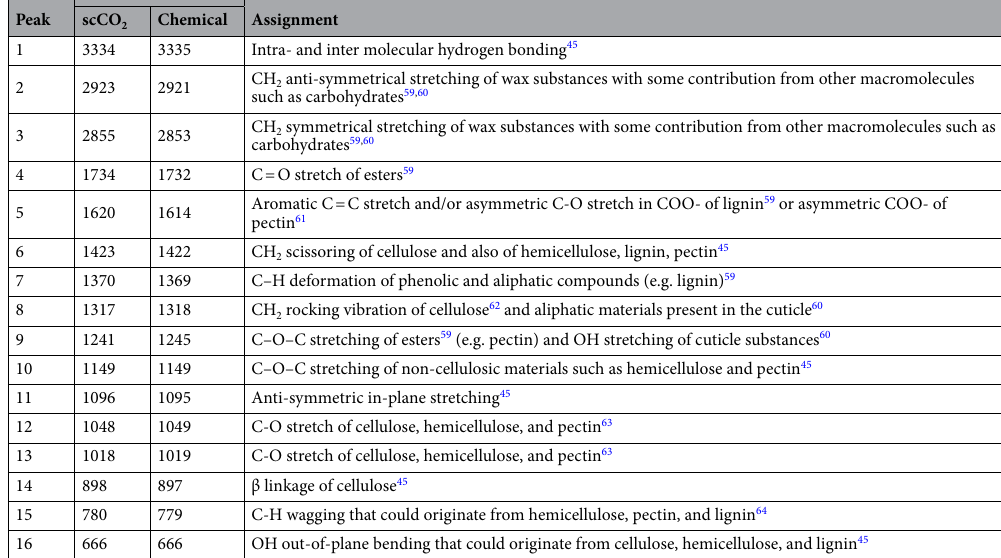
Table 1. Position of infrared bands in chemically and scCO 2 decellularized spinach leaf scaffolds with their functional group assignment.